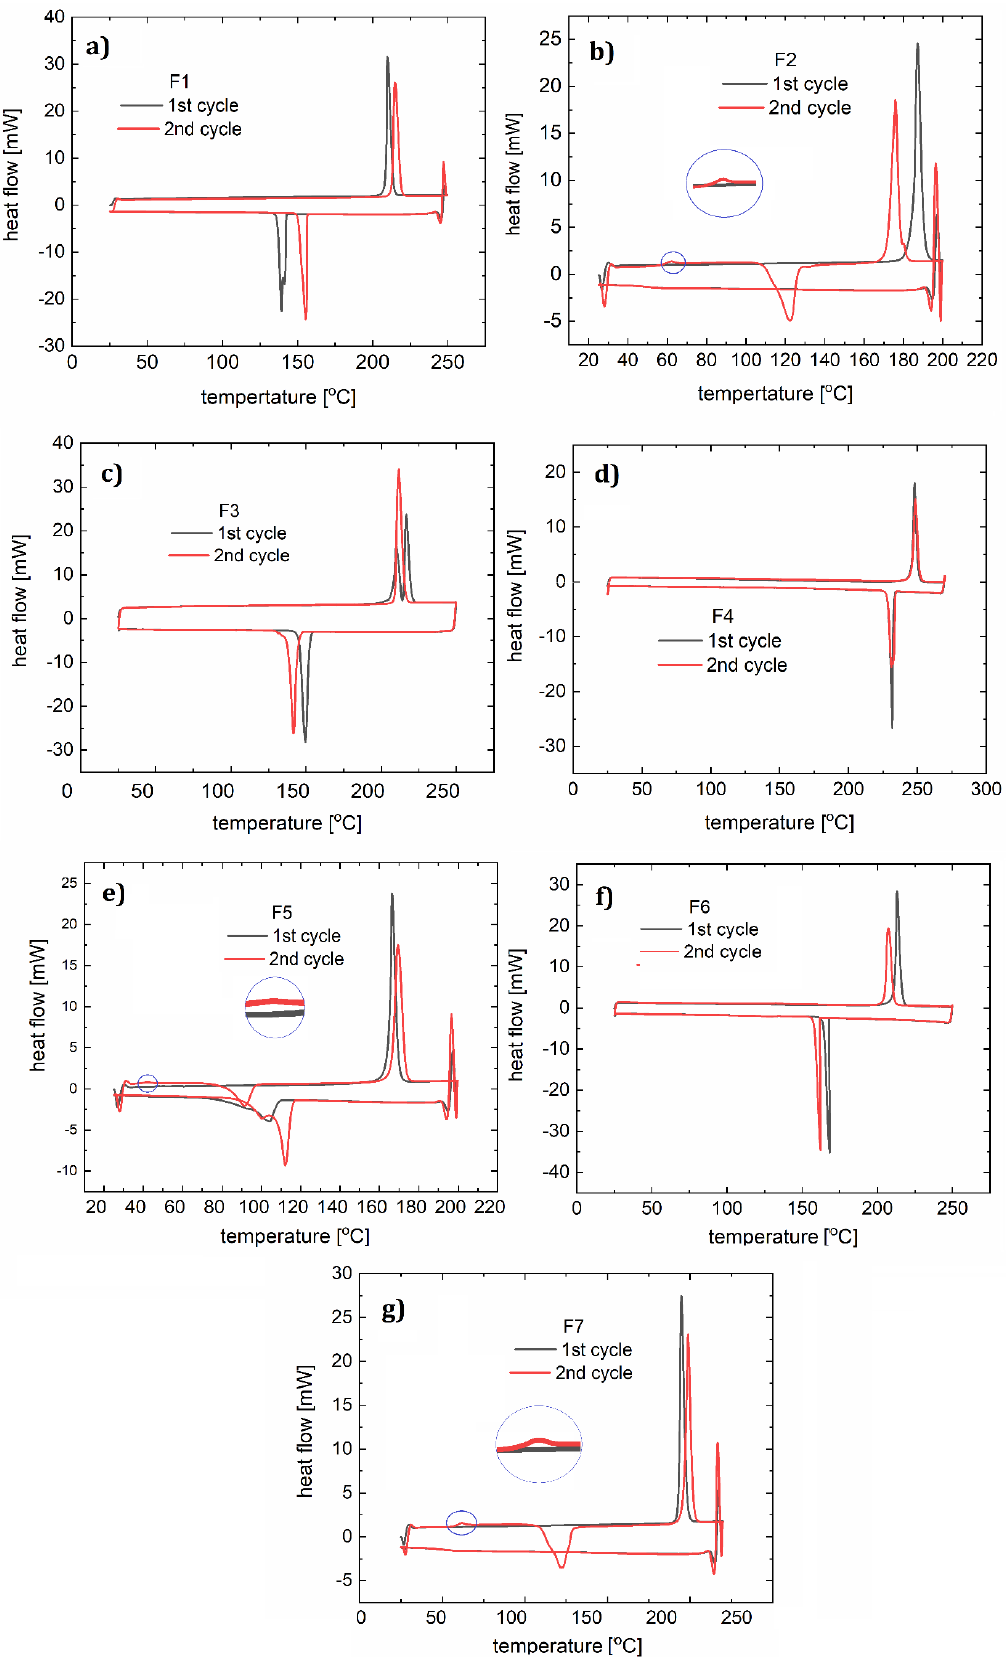
Figure 7. DSC curves with two heating and cooling cycles for: F1 ( a ), F2 ( b ), F3 ( c ), F4 ( d ), F5 ( e ), F6 ( f ), and F7 ( g ).